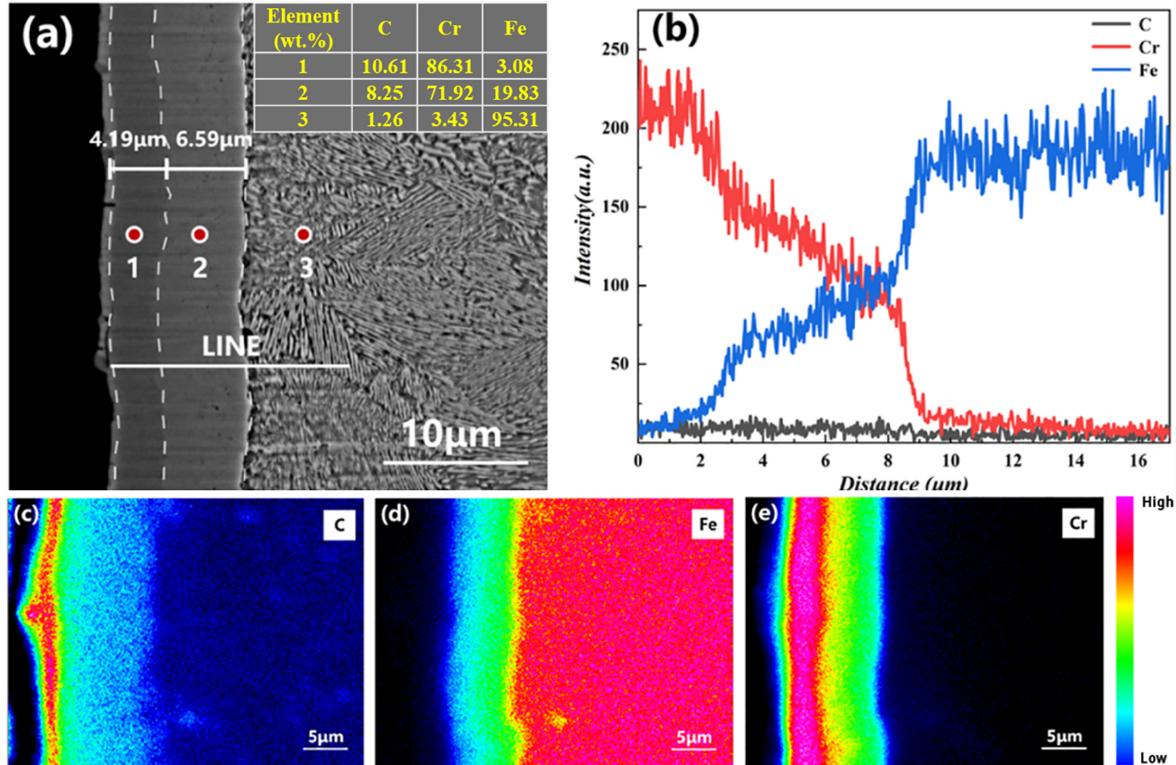
Figure 4. ( a ) Cross-section morphology of the chromized T9 steel. ( b ) Elemental distribution trend along the straight line shown in Figure 4a: surface scanning of the ( c ) C, ( d ) Fe, and ( e ) Cr distribu-